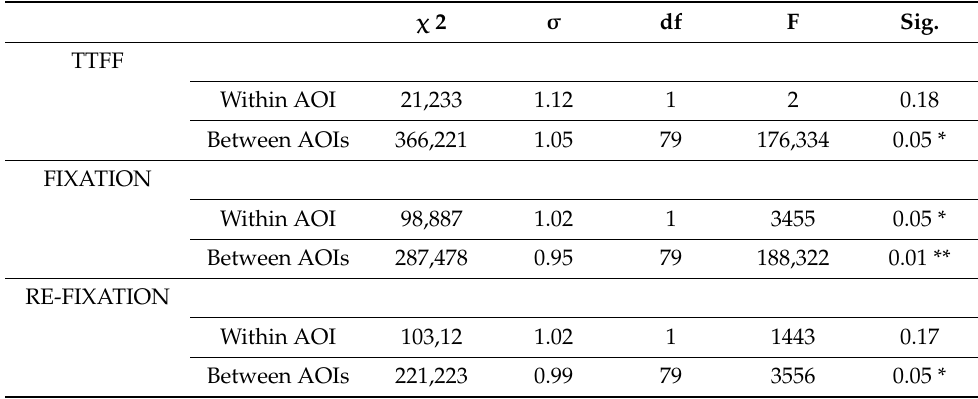
Table 6. AOI 12 ANOVA test S1